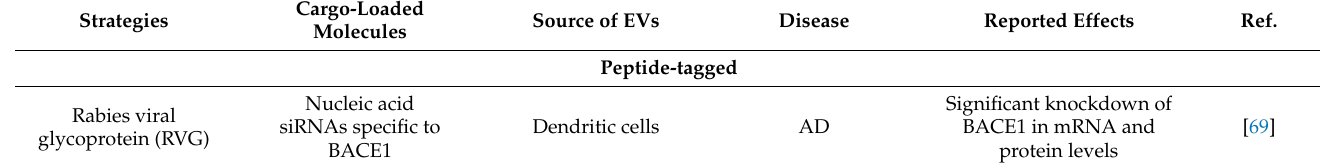
Table 3. A summary of strategies that enhance the efficacy of EV-based therapy for brain